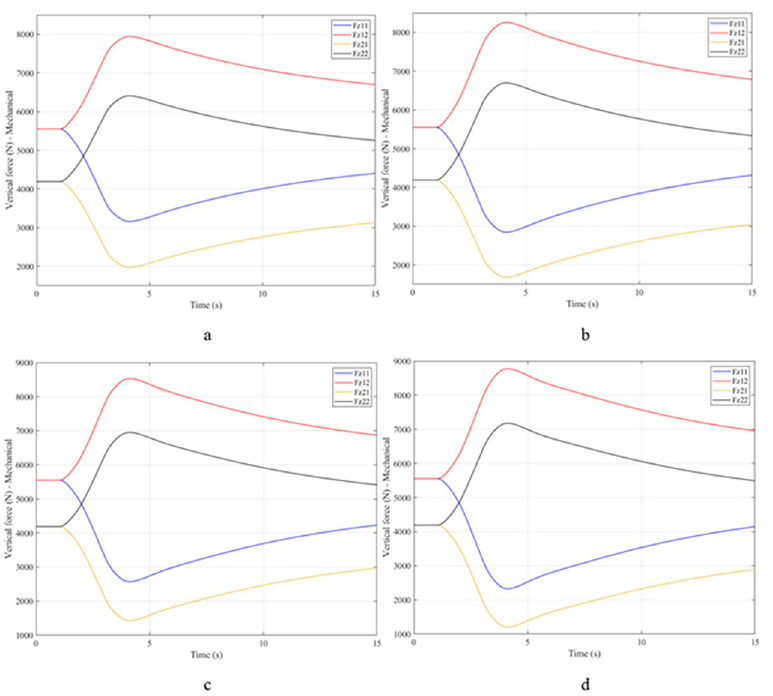
Fig 9. Vertical force–Mechanical.